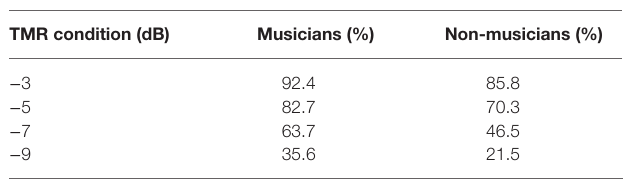
TABLE 2 | The percentage of correct recall as predicted by the final model across target-to-masker-ratio (TMR) conditions for both groups. Plogis transformed model estimates for the % of correctly recalled words by both groups TMR condition (dB)